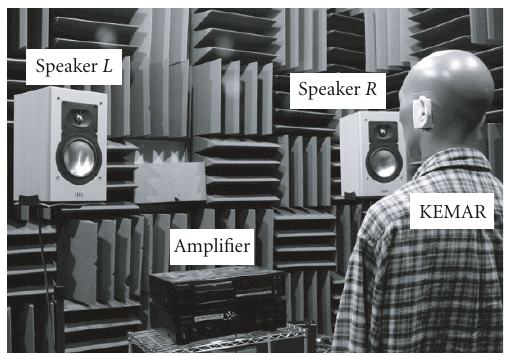
Figure 2: The experimental configuration.